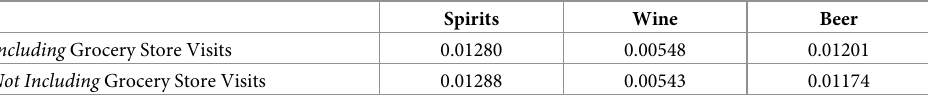
Spirits Wine Beer Including Grocery Store Visits 0.01280